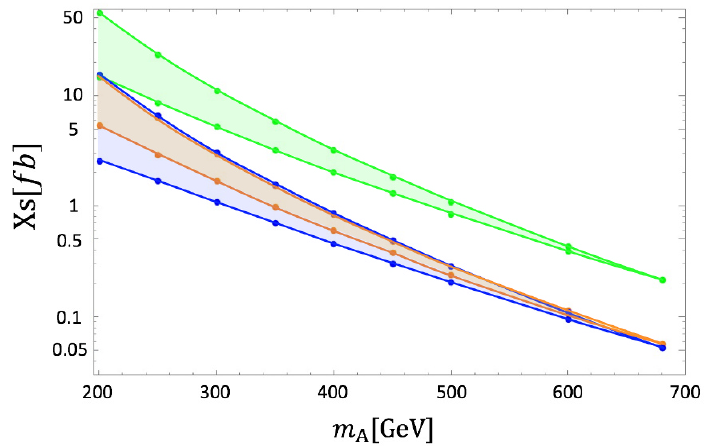
Figure 3 . The pair-production cross sections for (cid:30)H (cid:6) ( AH (cid:6) and HH (cid:6) are summed, green hatched), H (cid:0) H + (blue hatched), and HA (orange hatched) at the LHC with functions of m A . In the each process, the upper line is given by assuming j (cid:26) (cid:22)(cid:28) corresponds to the minimum (cid:1) H (cid:0) A , while the lower line is obtained by (cid:21) 5 =